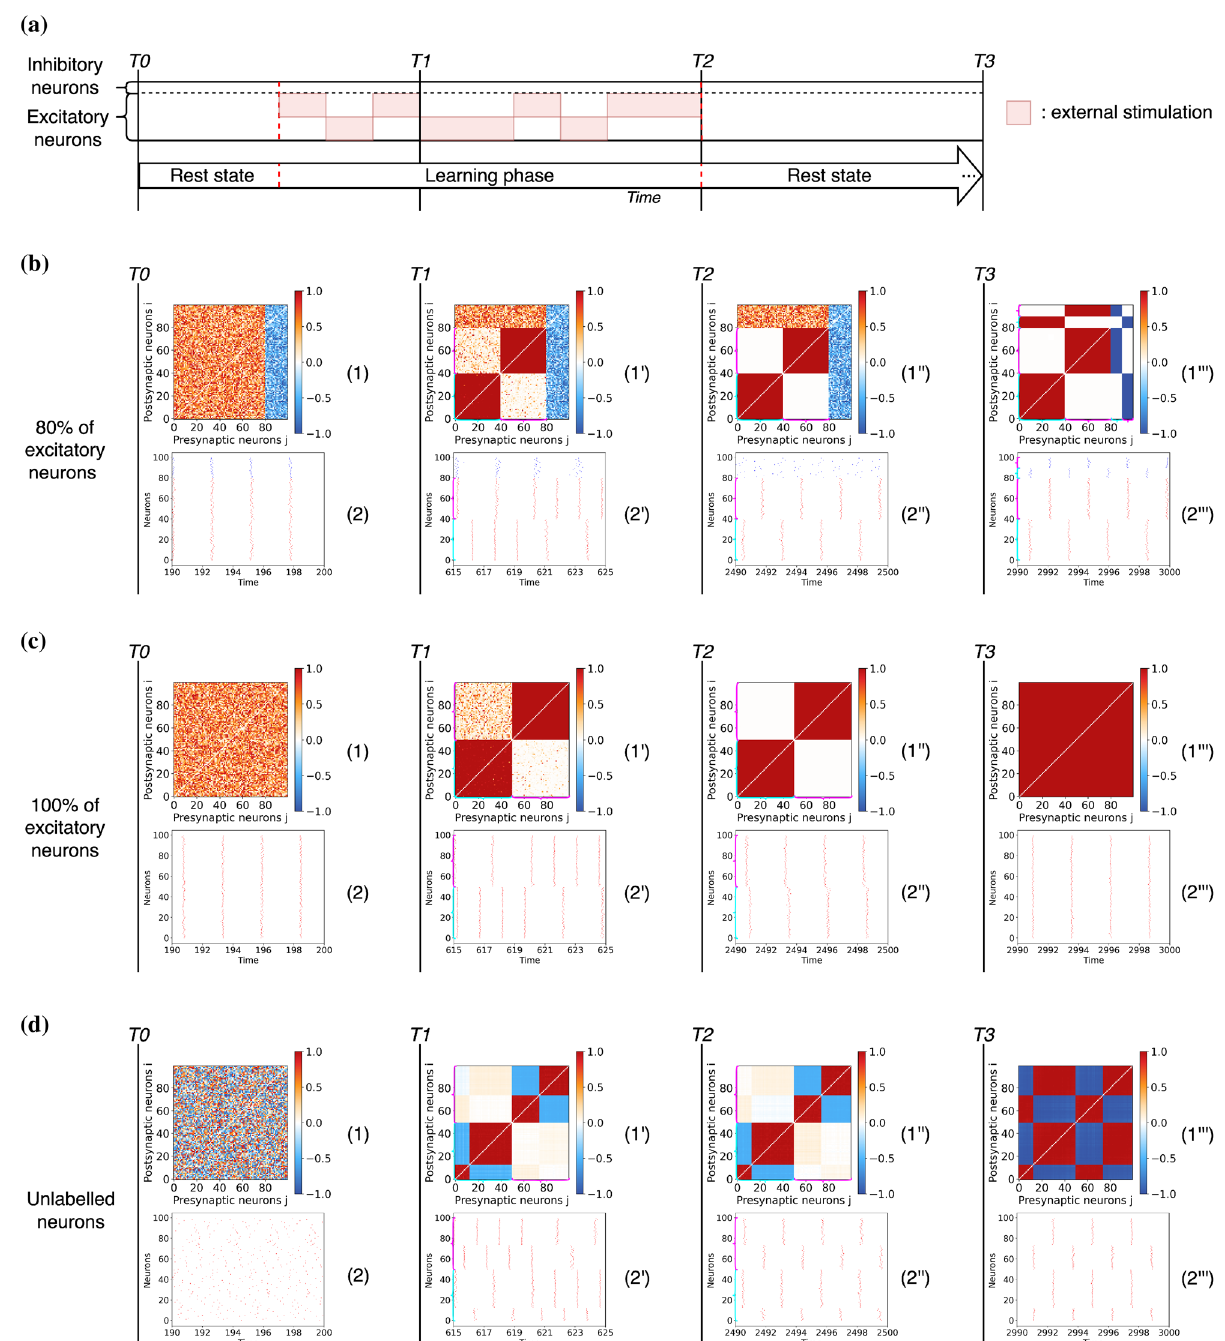
Figure 3. Entrainment of networks of θ -neurons defined by different combinations of excitatory and inhibitory connections. ( a ) Experimental protocol consisting of the stimulation of two non-overlapping neuronal populations of θ -neurons with plastic synapses. Stimuli are presented in temporal alternation. ( b ) Results for a network with 80% excitatory and 20% inhibitory neurons. ( c ) Results for a network of only excitatory neurons and ( d ) for unlabelled neurons projecting both excitatory and inhibitory postsynaptic connections. The results are reported at different moments of the stimulation. The time T0 corresponds to the beginning of the t t 190 simulation before the learning phase, after a transient period has been discarded. The time T1 corresponds to an early = moment during the learning phase. Time T2 corresponds to the end of the learning phase and the beginning of the resting-state. The time T3 corresponds to the end of a long period of spontaneous activity during which synaptic weights are consolidated. Panels labelled (1), (1’), (1”) and (1”’) represent the weight matrices at times T0, T1, T2 and T3: the color denotes if the connection is excitatory (red) or inhibitory (blue) or absent (white). Panels (2), (2’), (2”) and (2”’) are raster plots at times T0, T1, T2 and T3, displaying the firing times of excitatory (red dots) and inhibitory (blue dots) neurons. Note that the inhibitory neurons are sorted by phases at time T3 in the weight matrices and raster plots reported in ( b,c ); while the neurons are sorted by phase in the weight matrices and raster plots within each cluster at times T1, T2 and T3 of the row ( d ). The cyan and magenta brackets represent clusters 1 and 2 respectively when they are visible in weight matrices and raster